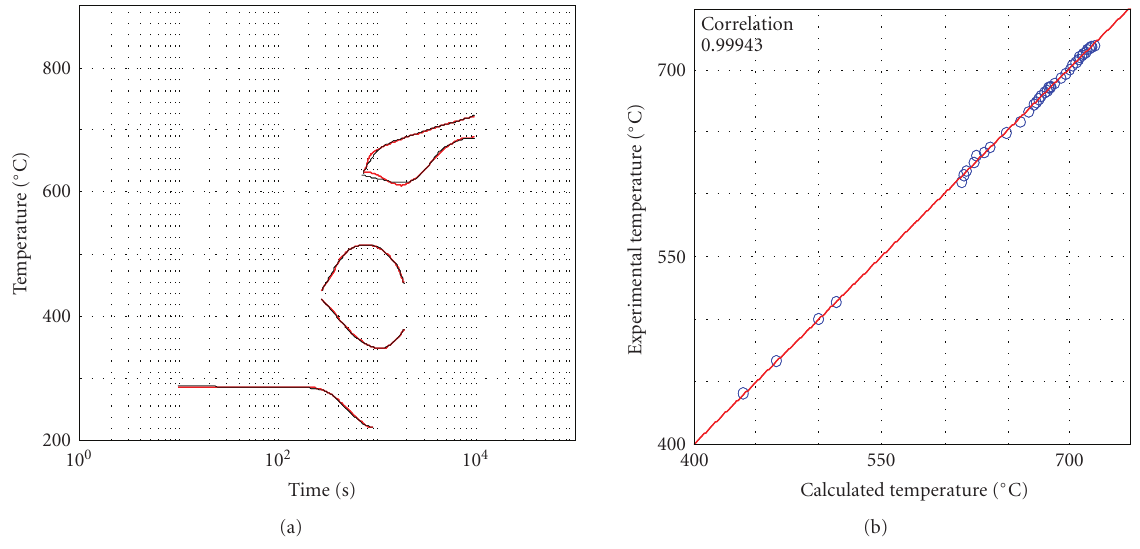
Figure 13: Results for tempering steel 51CrV4 with a deformation of